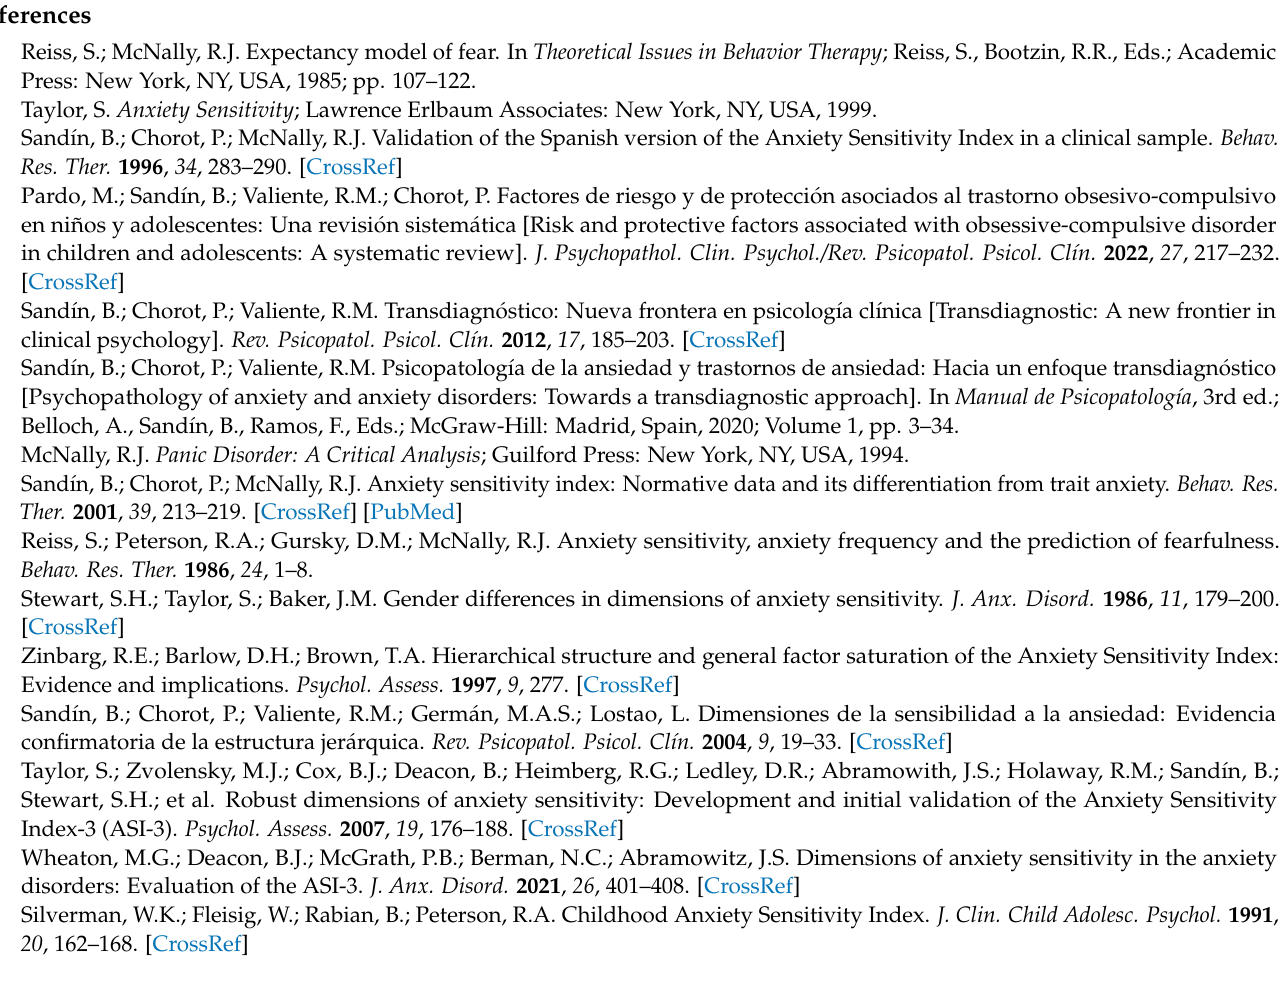
18. Me asusto cuando siento en mi cuerpo sensaciones raras o inesperadas